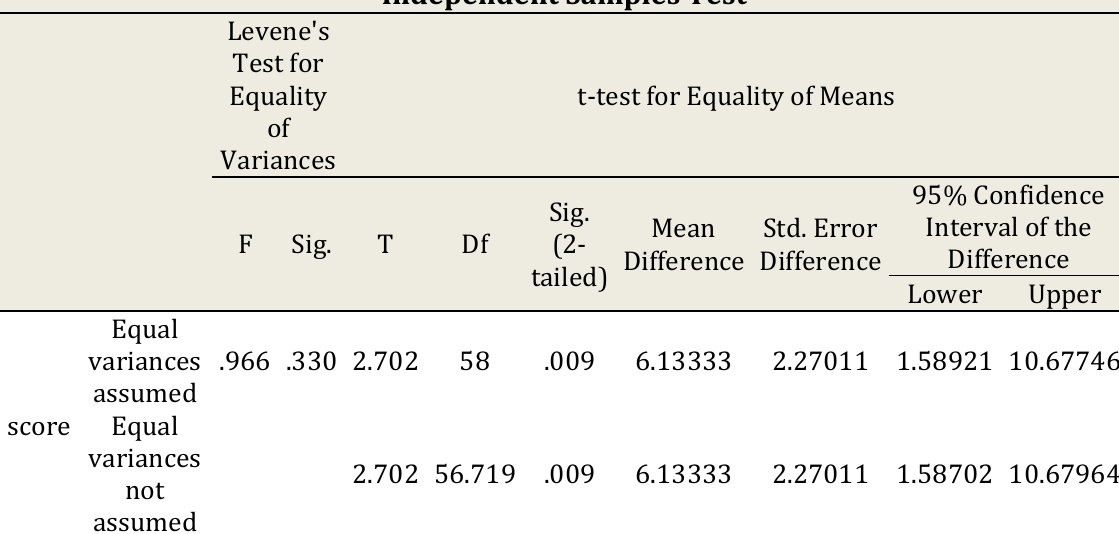
Table 7. the probability value of t-test of pre-test in experimental and control classes